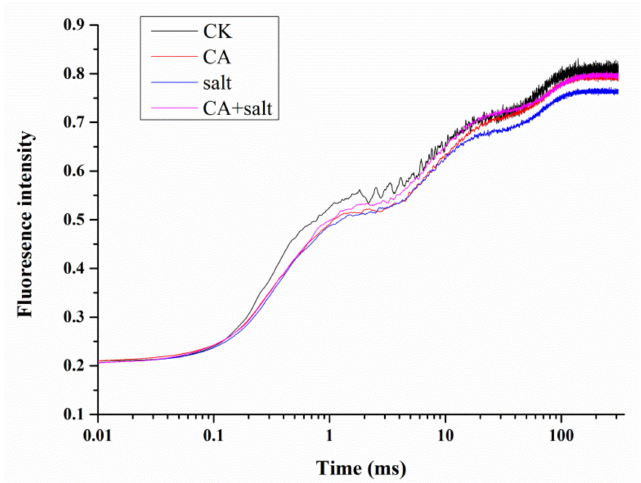
Figure 4. Chlorophyll (Chl) a fluorescence transient in bermudagrass under di ff erent treatments. CK = control; CA = pre-cold treatment for 6 h; salt = 150 mM NaCl treatment for 1